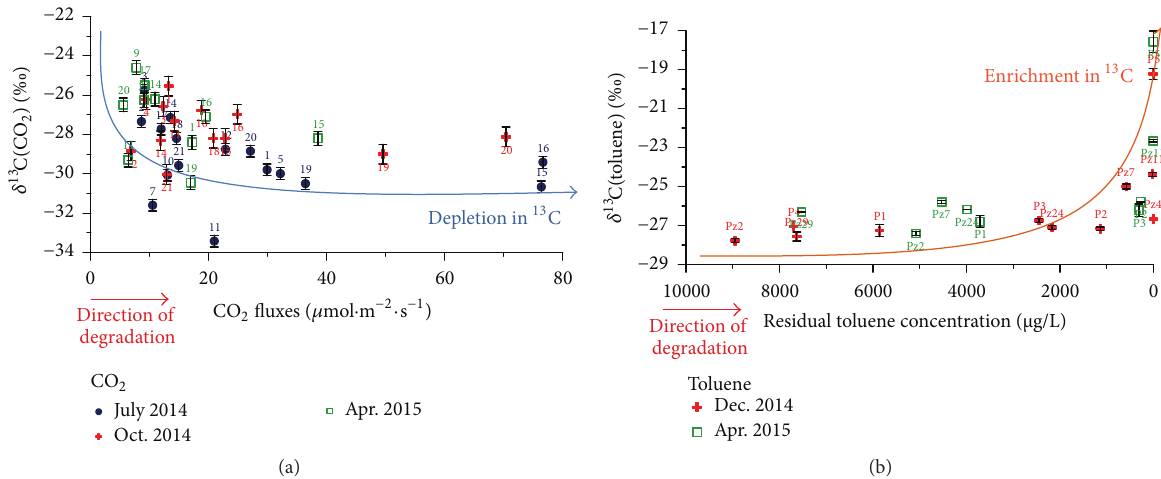
Figure 12: Carbon isotopic ratio versus VPDB of CO 2 (a) in function of CO 2 fluxes at the ground surface and carbon isotopic ratio versus VPDB of residual toluene (b) as a function of toluene concentrations in